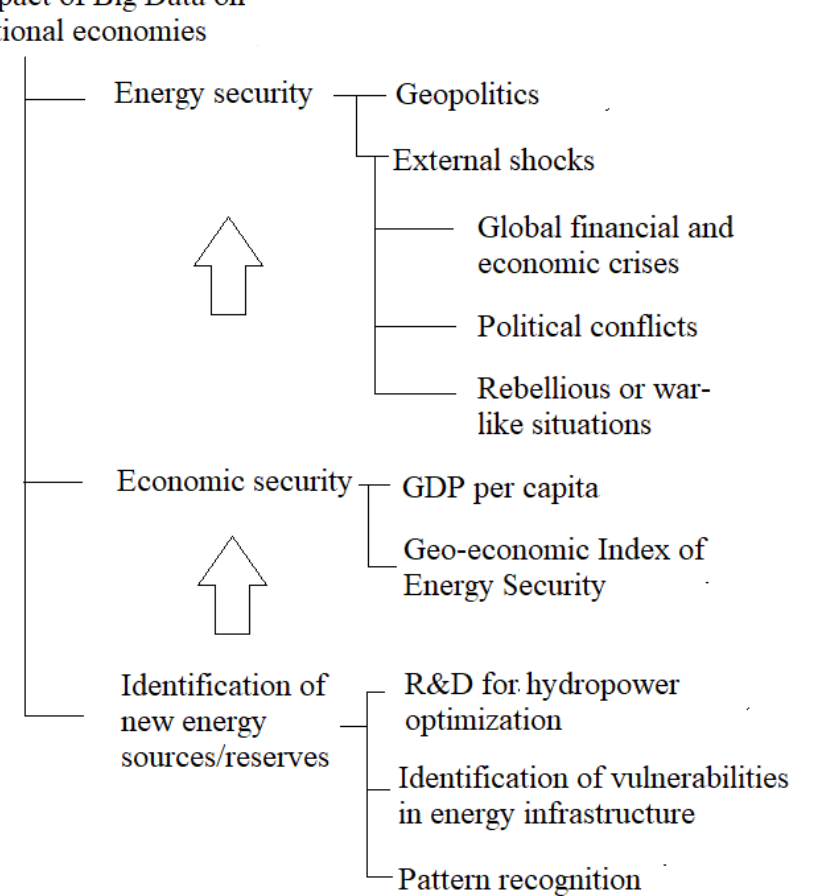
Figure 2. Flowchart diagram: Drivers of the Impact of Big Data on national economies and factors affecting energy security.